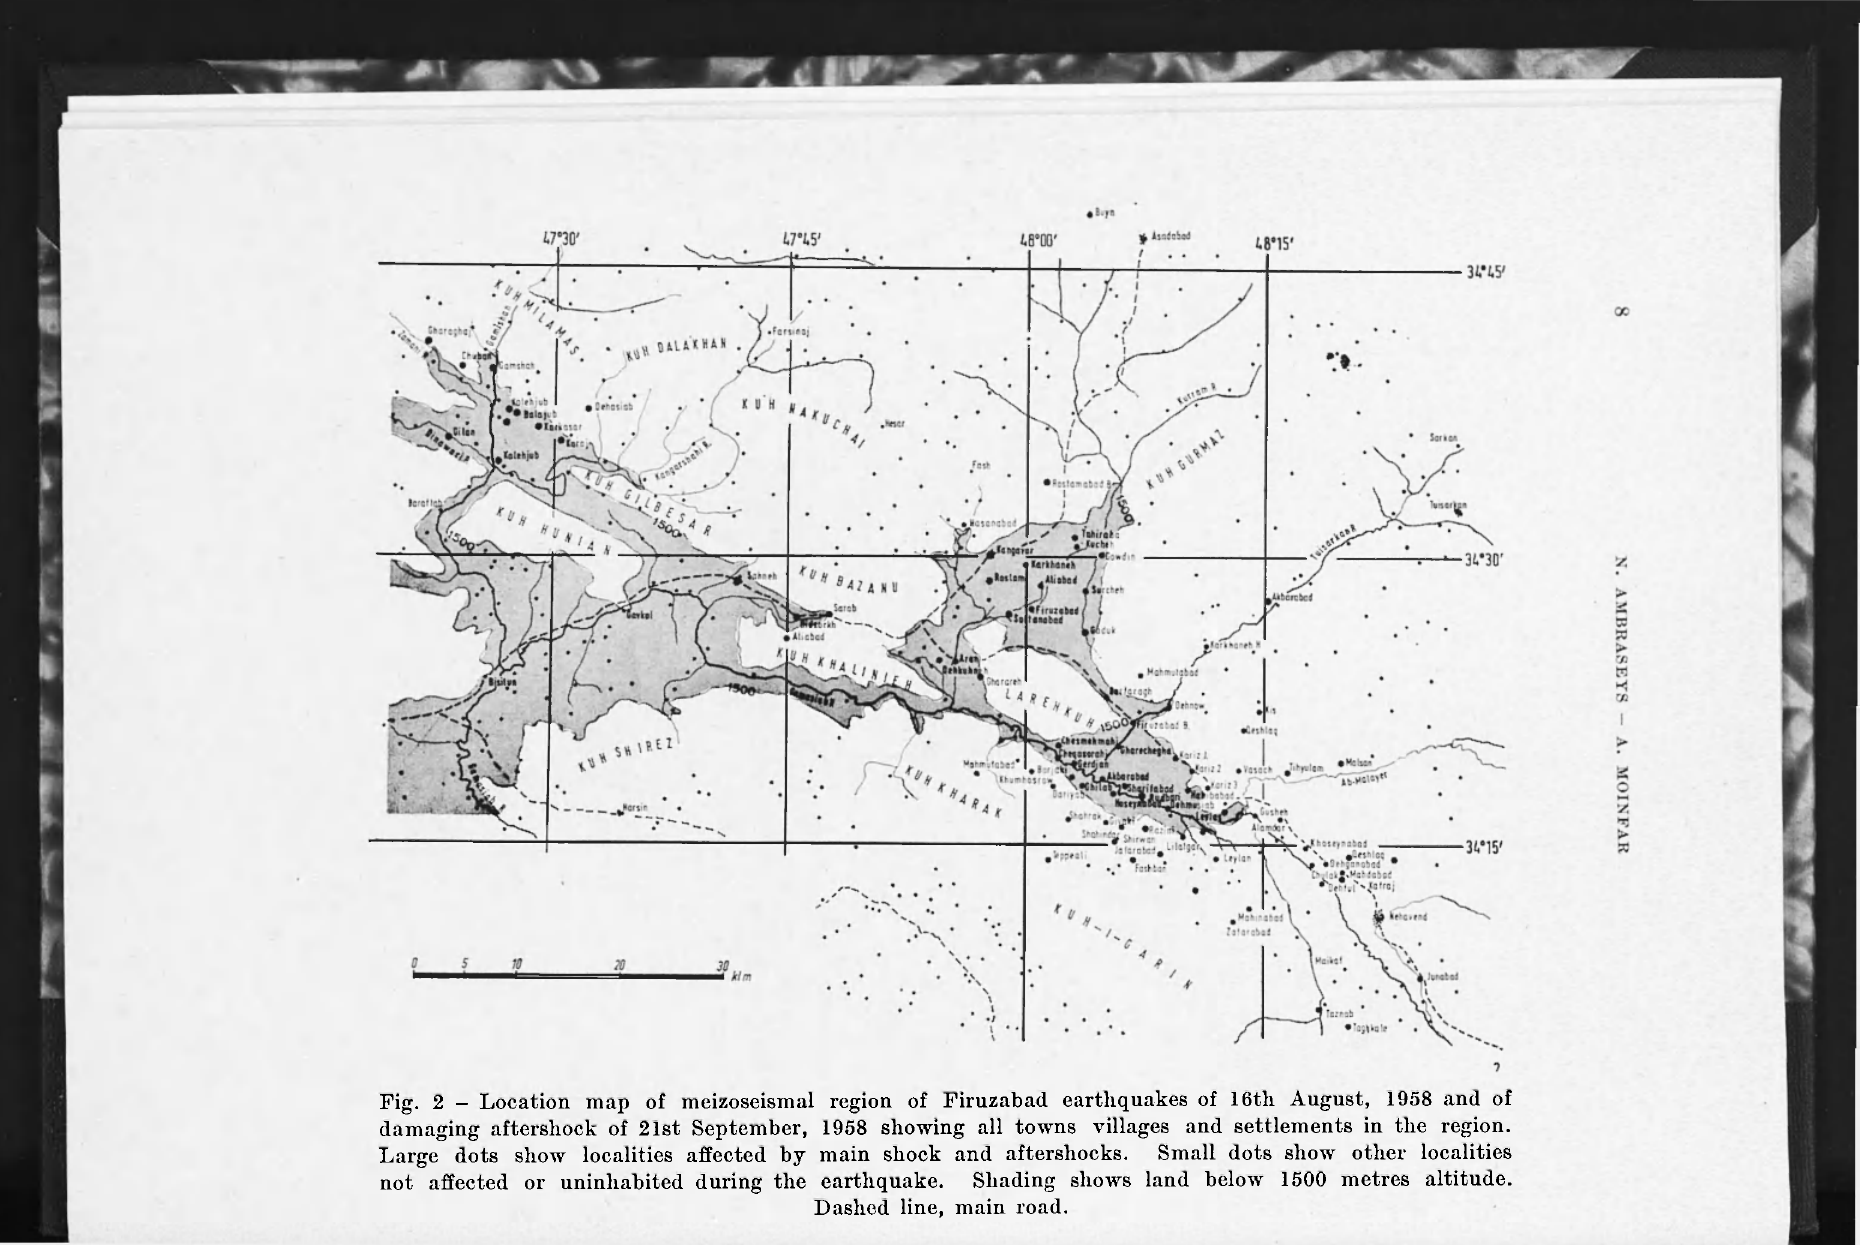
Fig. 2 - Location map of meizoseismal region of Firuzabad earthquakes of 16th August, 1958 and of damaging aftershock of 21st September, 1958 showing all towns villages and settlements in the region. Large dots show localities affected by main shock and aftershocks. Small dots show other localities not affected or uninhabited during the earthquake. Shading shows land below 1500 metres altitude. Dashed line, main